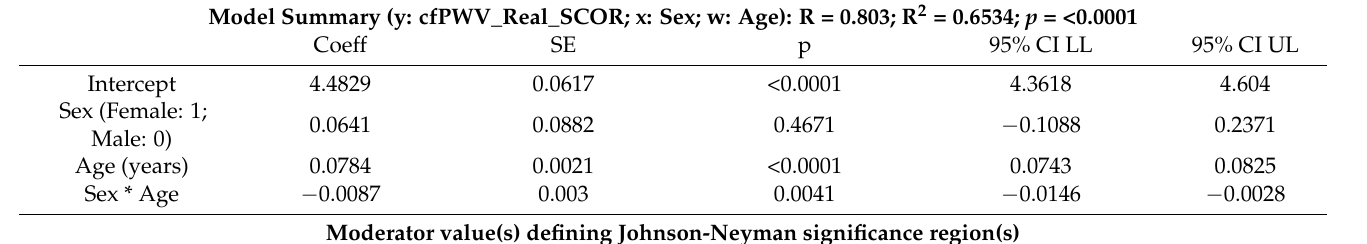
Fifth, we evaluated whether it was necessary to define sex-specific RIs using: (i) bi- variate partial correlations (age-adjusted) and (ii) interaction analysis (Sex*Age) with theJohnson-Neyman significance regions definition (Table 7). Variables “y”, “x” and “w” (moderating variable) were assigned, respectively, to the stiffness parameter (e.g., cfPWV_Real_SCOR), sex and age. Then we identified: (i) parameters that would require RIs for males and females only from a certain age (cfPWV_Real_SCOR and crPWV_SCOR),